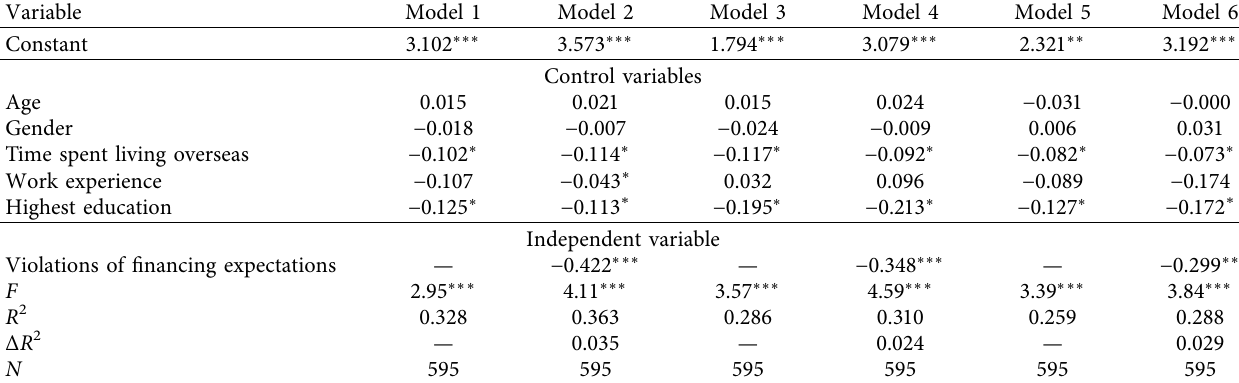
Table 4: Preliminary regression